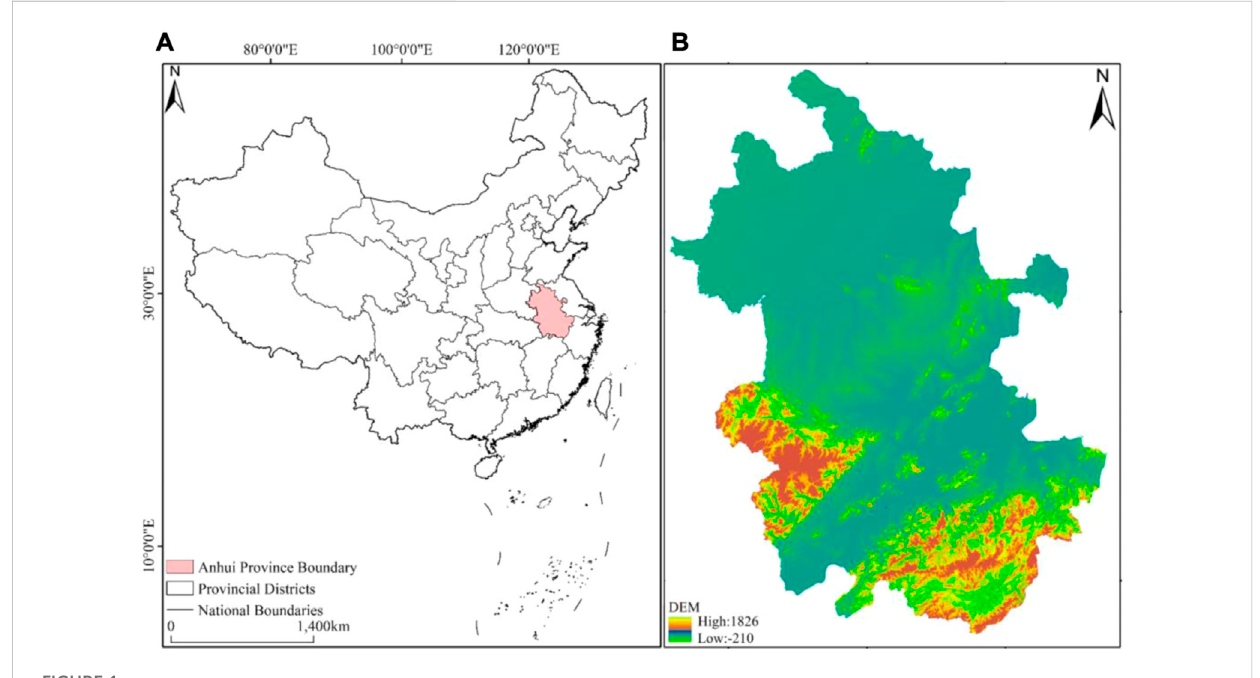
FIGURE 1 Location map of the study area. (A) China, (B) Anhui province